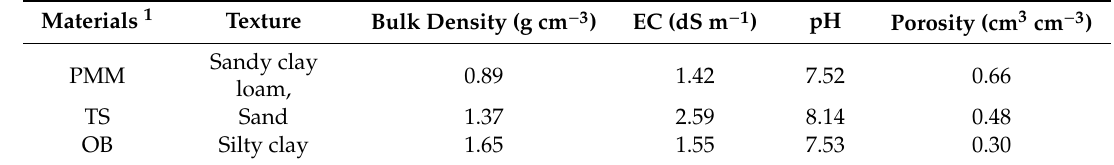
Table 2. A list of treatment codes and details of the design.